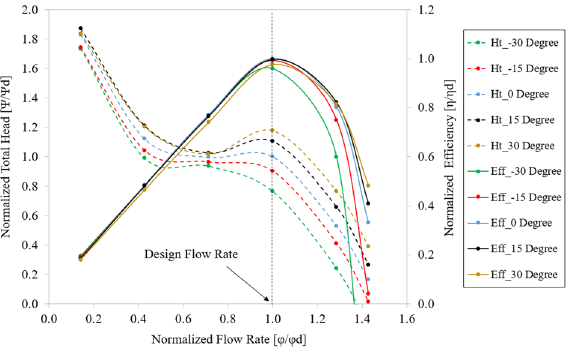
Figure 19. Hydraulic performance curves of axial-flow pump with different IGV’s setting